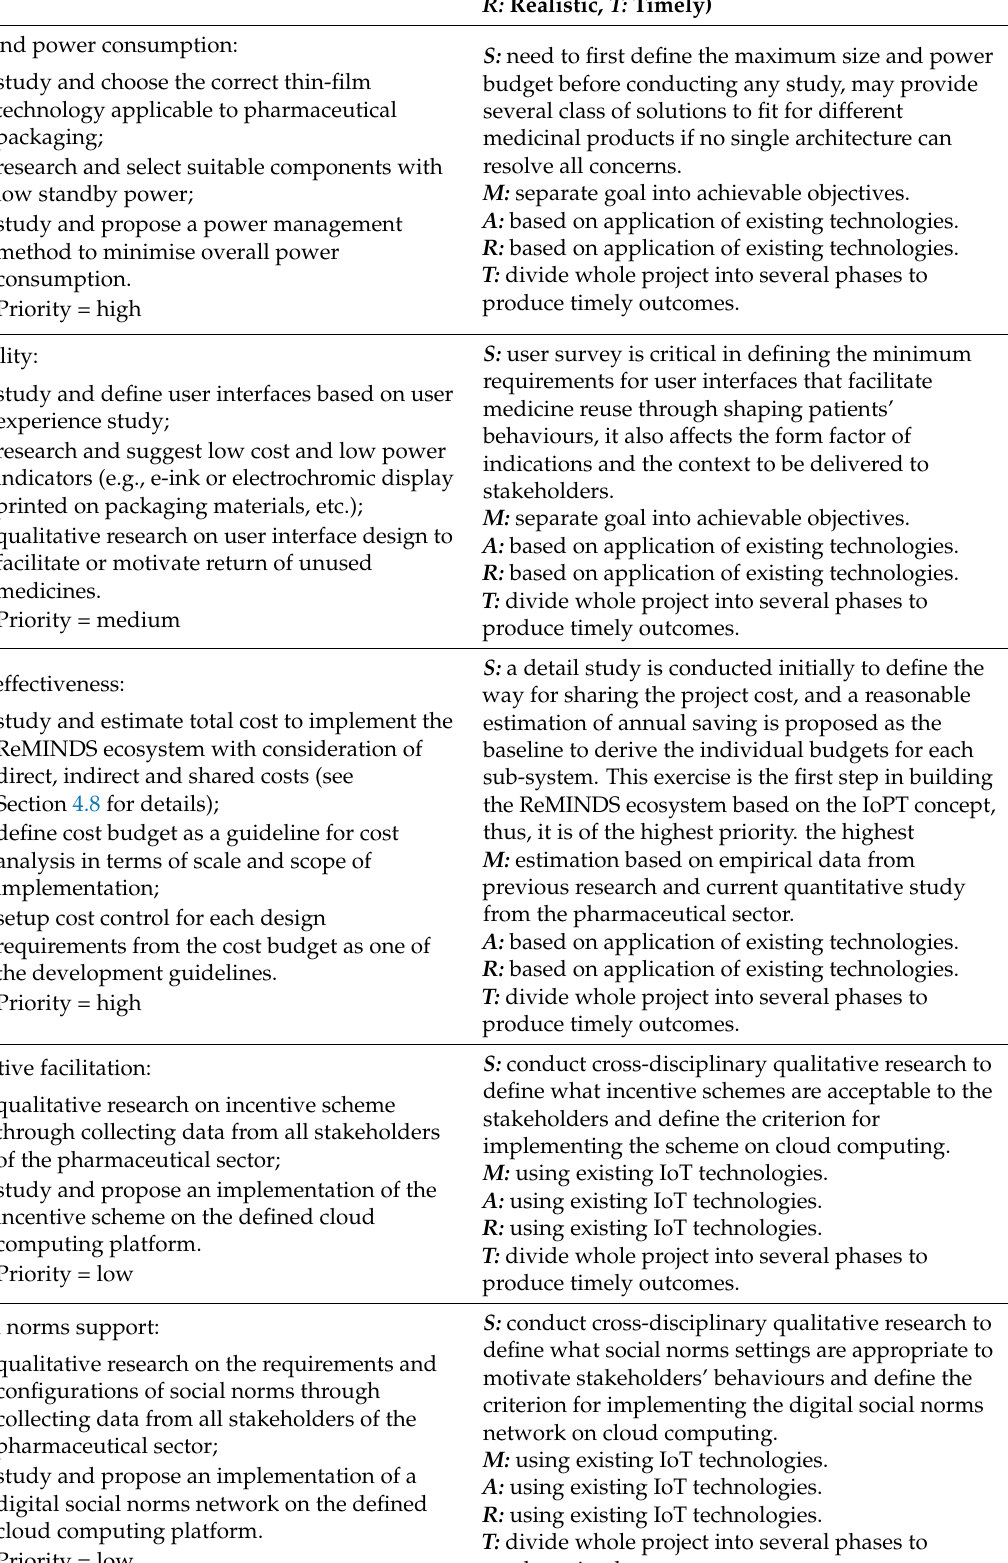
Proposed Development Requirements